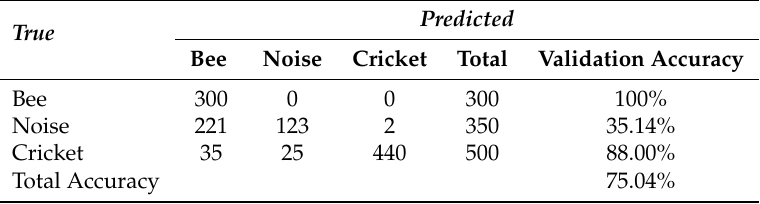
Table A8. Confusion matrix for ConvNet 3 with receptive field size n = 30 on BUZZ1 validation dataset.